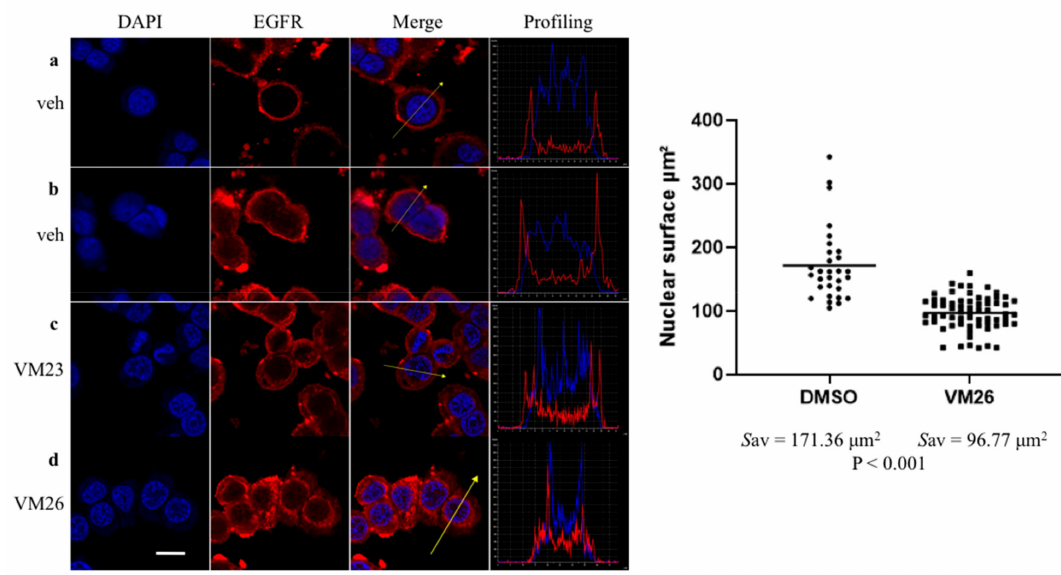
Figure 4. EGFR rapidly responds to the chemical invasion of small compounds in cancer cells. Immunofluorescence detection was carried out with anti-EGFR mAb (the epitope in the extracellular domain). Fluorescence in nonpermeabilized ( a ) and permeabilized ( b ) cells after exposure to vehicle and in permeabilized cells after exposure to VM23 ( c ) and VM26 ( d ). MDA-MB-468 cells were incubated with VM23 and VM26 as described in Figure 3c. Profiling curves of fluorescent signal distribution in representative cells are shown with dashes in merge. ( e ) Boxplot histogram of a 2D square of nuclei surfaces upon exposure to vehicle and VM26. S av is the average square of the nuclear surface in cells. The size bar is equal to 10 µ